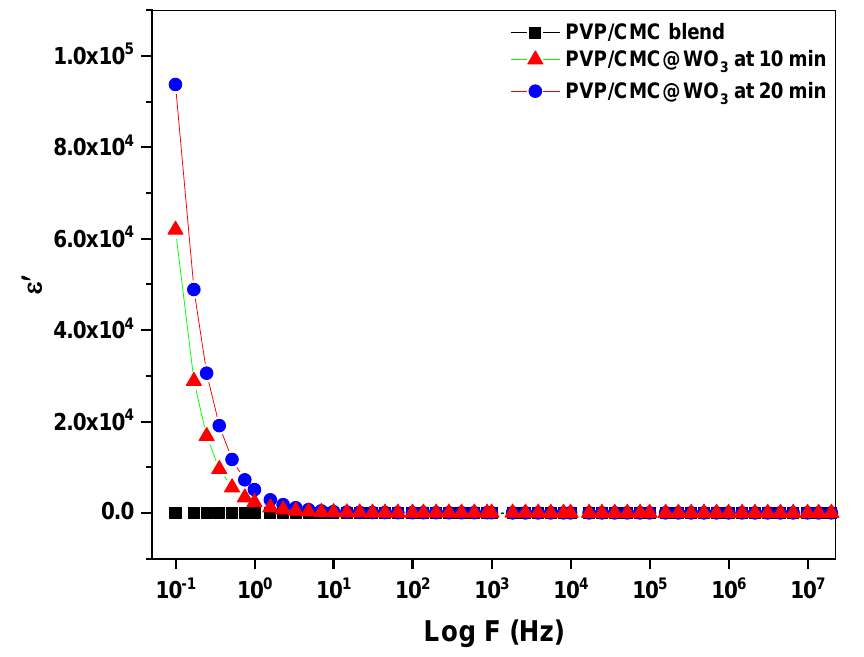
Figure 6. The real part (ε′) versus log f for PVP/CMC and PVP/CMC -WO 3 at two laser-ablation times (10 and 20 min).